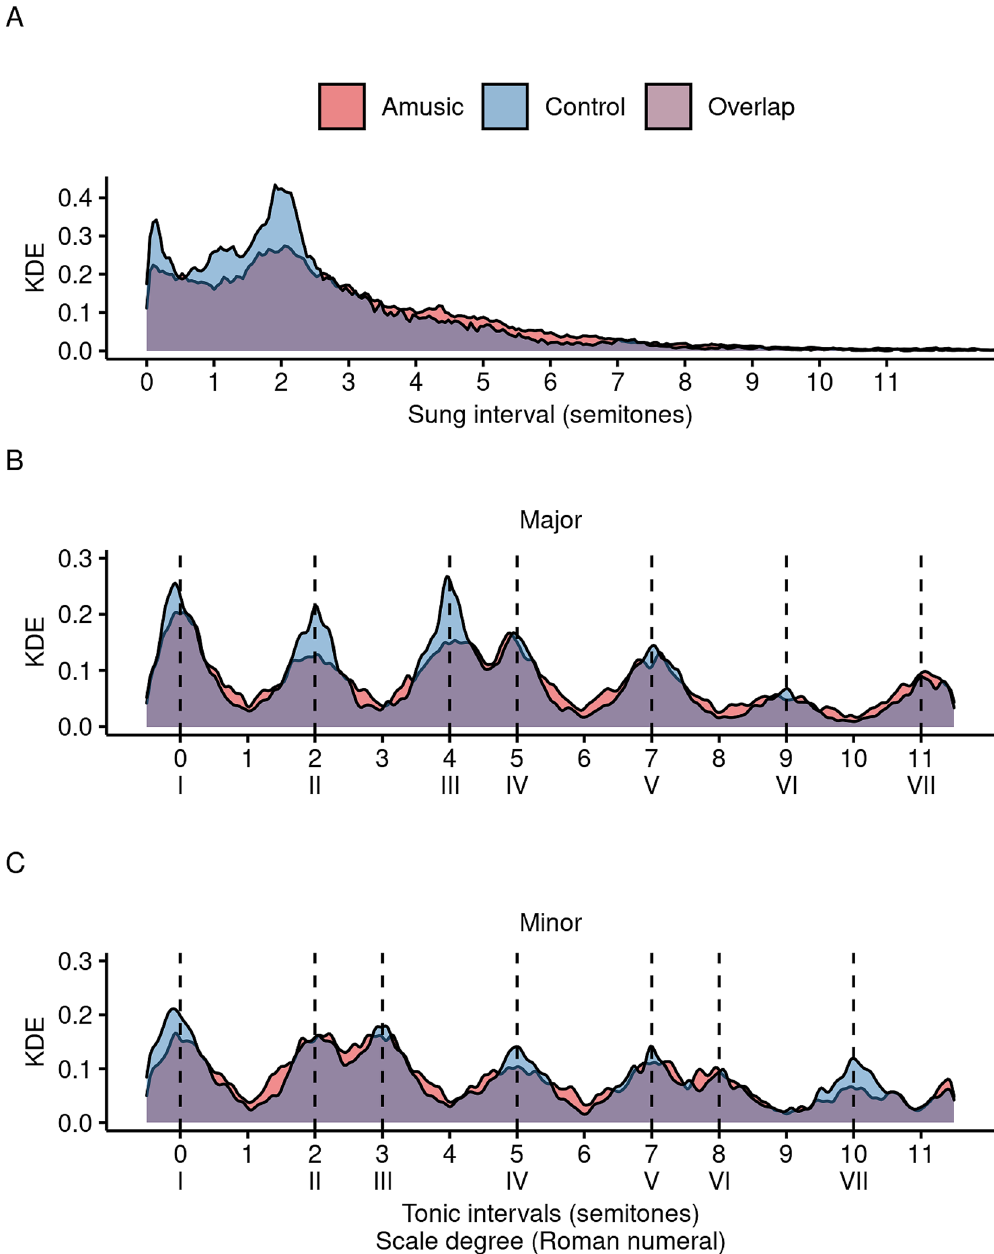
Figure 2. ( A ) shows the distribution of sung intervals (comprising both ascending and descending intervals) in improvisations by group. Intervals beyond 12 semitones were infrequent and are omitted for clarity. ( B ) and ( C ) show the density plot of all notes sung during improvisations relative to the tonic. Vertical dashed lines represent intervals in-scale by mode. Supplementary Fig. S7 displays panels ( B ) and ( C ) alongside a density plot derived from the null distribution used in the z-score analysis. KDE = Kernel density estimate, an estimate of the probability density function; kernel bandwidth =